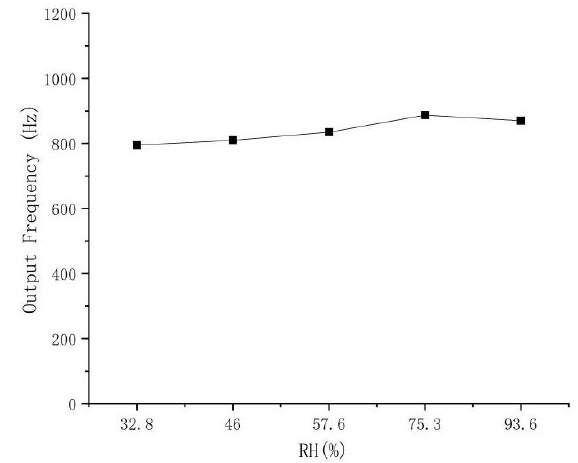
Figure 15. Experiment of humidity